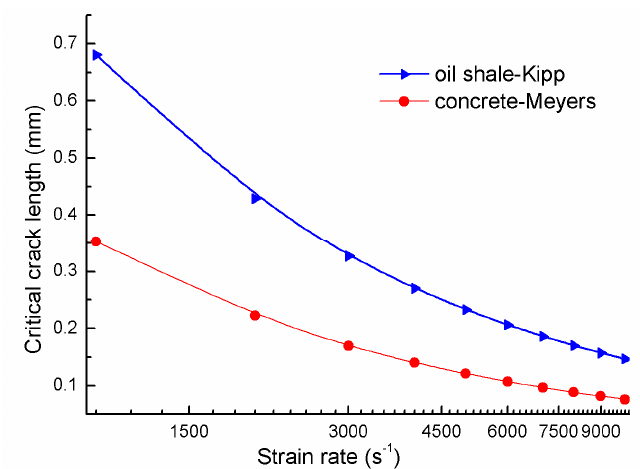
Figure 4. Critical crack length vs. loading